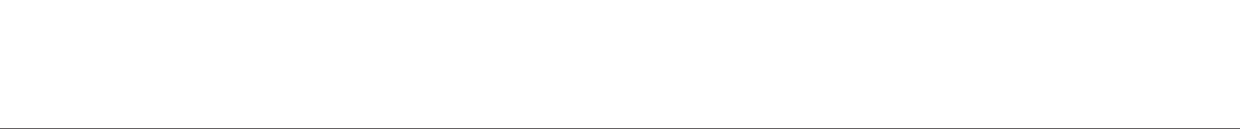
Frontiers in Nutrition |